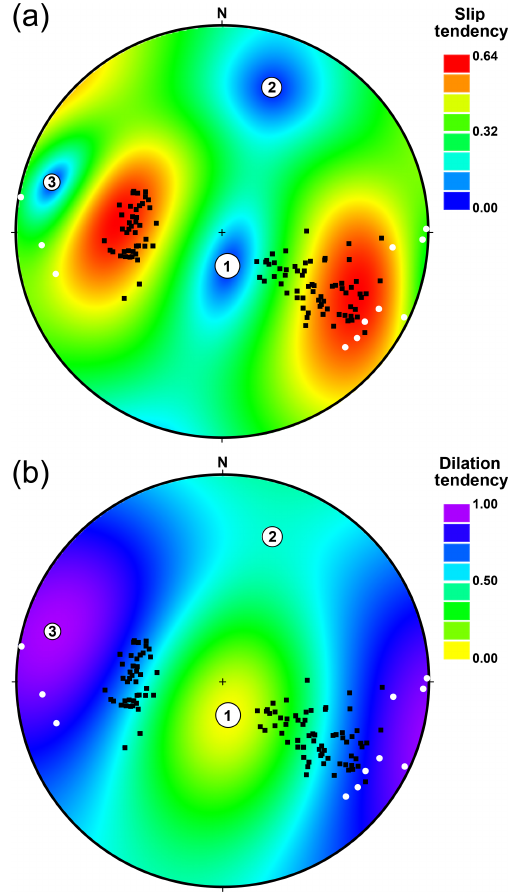
Figure 3. Equal-angle stereonet plots of (a) slip tendency and (b) dilation tendency with poles to shear segments (black dots) and calcite-cemented dilational segments (white dots) measured from the Textbook, Spanish Goat, and Big Indigo faults at Sycamore Bluffs. Larger dots labeled 1, 2, and 3 represent orientations of the maximum, intermediate, and minimum principal compressive stresses, σ 1 , σ 2 , and σ 3 , respectively. See text for further discussion of the inferred stress